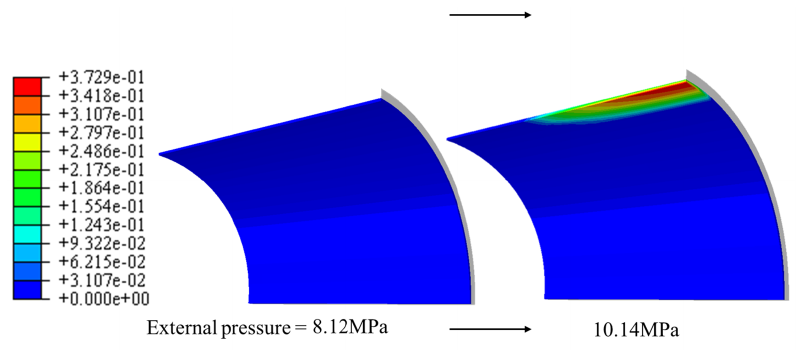
Figure 15. Scalar stiffness degradation for cohesive surfaces.